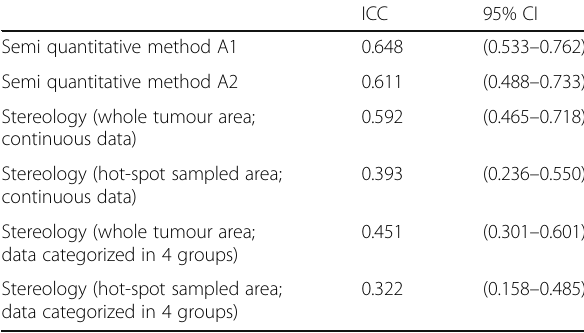
Table 2 Intra-class correlation coefficients (ICC) for estimates of tumour stroma